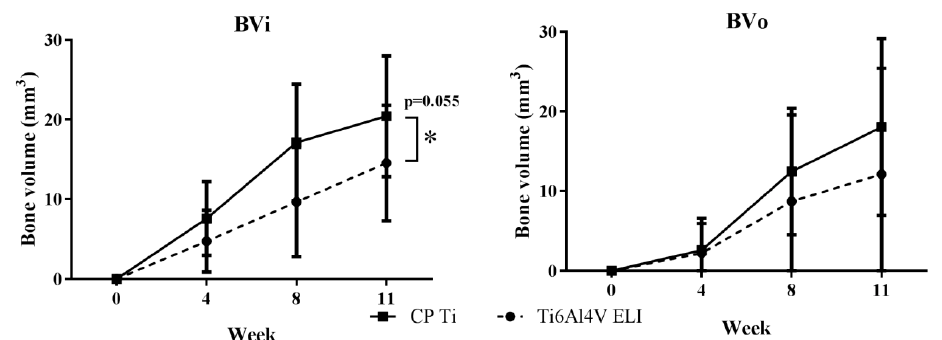
Figure 3. Longitudinal quantification of bone regeneration. In vivo µ CT scans after zero, four, eight, and eleven weeks; BVi and BVo: defined as bone formed inside and outside the porous space and in the medullary canal of the titanium implants. Values are expressed as mean and SD (n = 8 for CP-Ti and n = 8 for Ti6Al4V-ELI). * indicates (borderline) significant differences between groups.